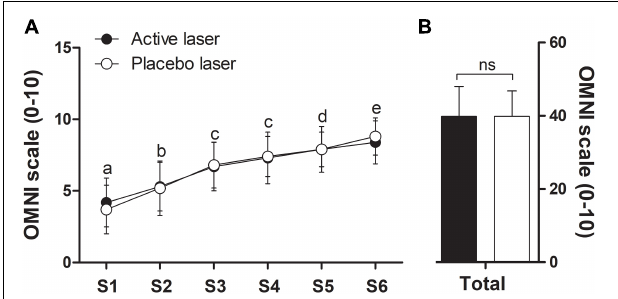
FIGURE 3 | Number of repetitions to failure over six sets (S1–S6) (A) and corresponding total repetitions (sum of all sets) (B) during elbow flexion exercise in the active and placebo laser conditions ( N = 13). Data are means ± SD. There were no significant ( p > 0.05) differences over time between conditions. Different letters indicate significant ( p < 0.05) difference between time points for both groups.